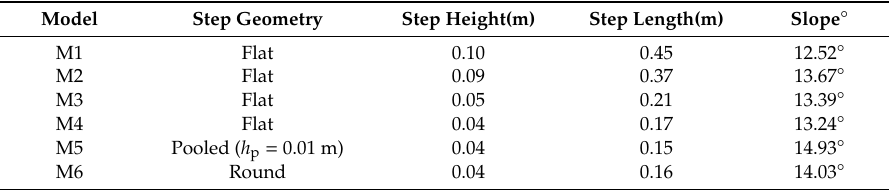
Table 1. Design parameters of di ff erent stepped spillways for numerical